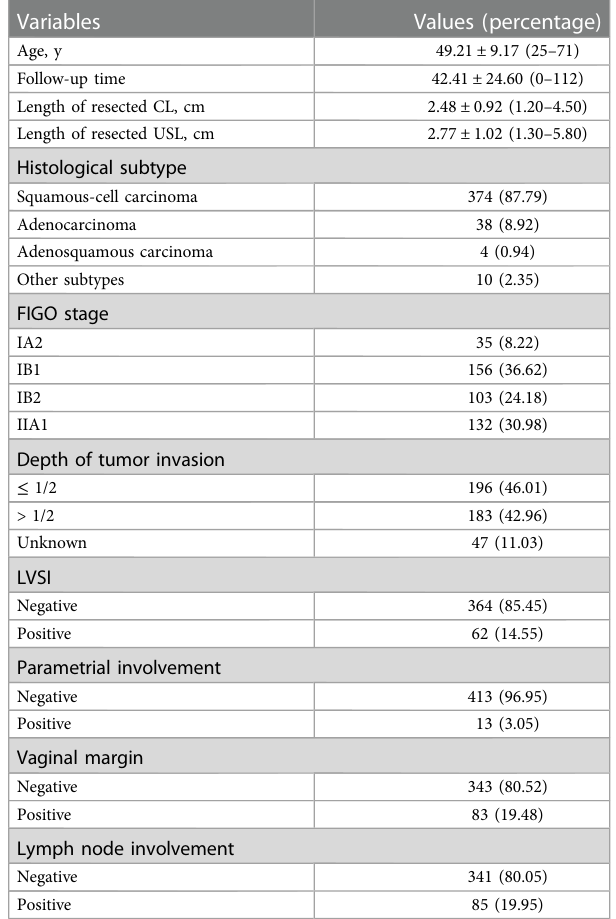
TABLE 1 Clinicopathological characteristics of inclusive early-stage cervical cancer patients ( n